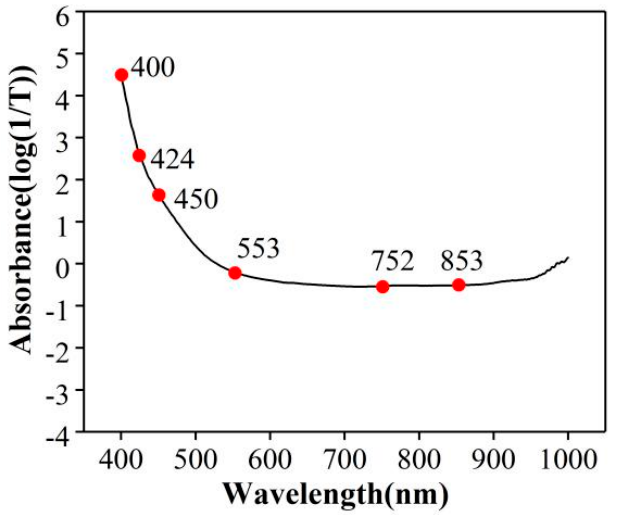
Figure 5. Characteristic wavelengths of the spectra based on the pretreatment of GF-SNV. SPA selected 6 characteristic wavelengths in red dot.